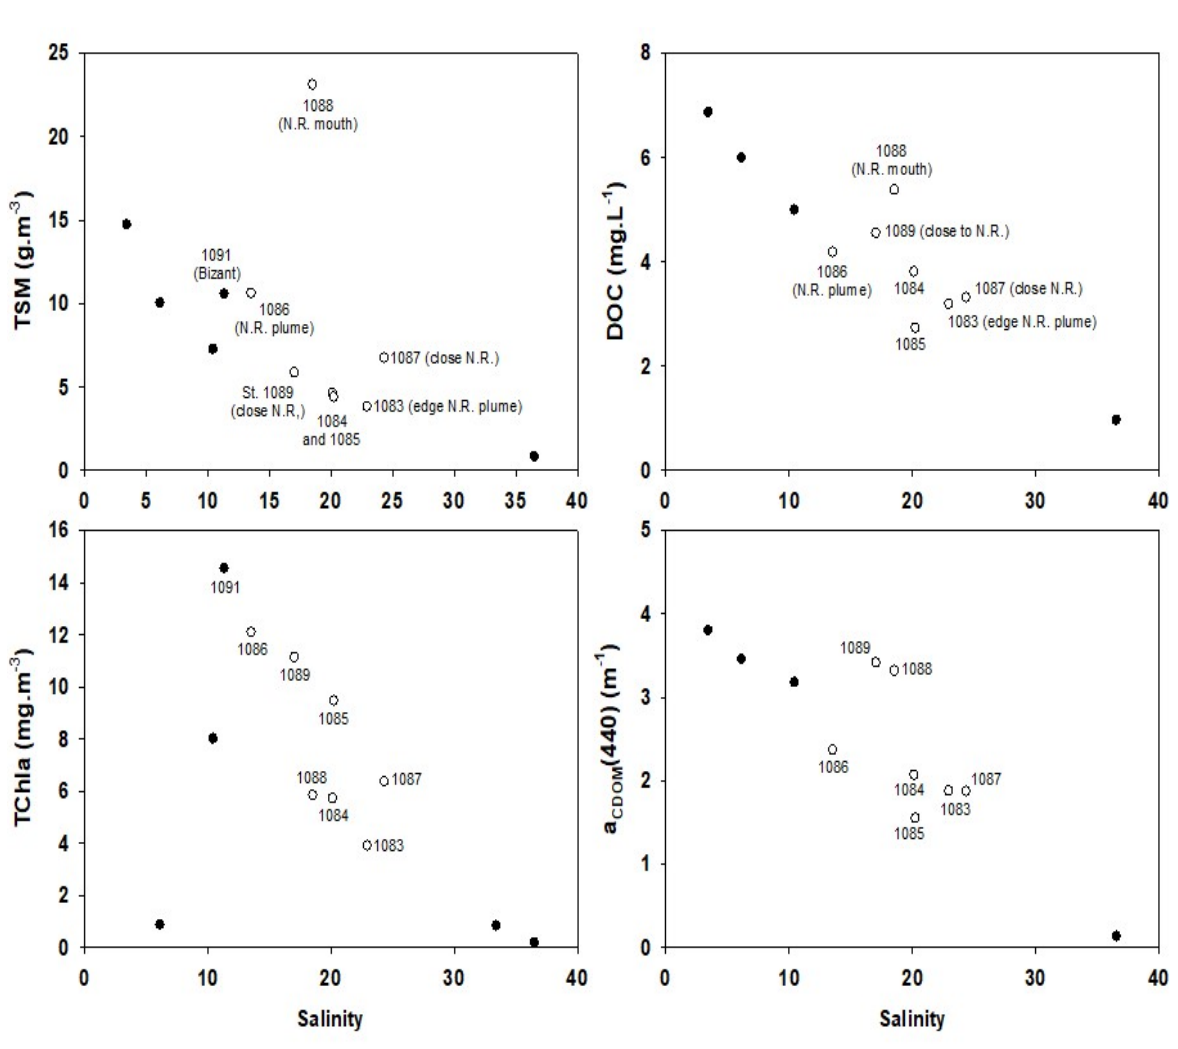
Figure 10. Biogeochemical quantities (TSM, TChl a , DOC, and a CDOM (440)) versus Salinity. White circles denote the stations in the region impacted by the Normanby river flood plume.